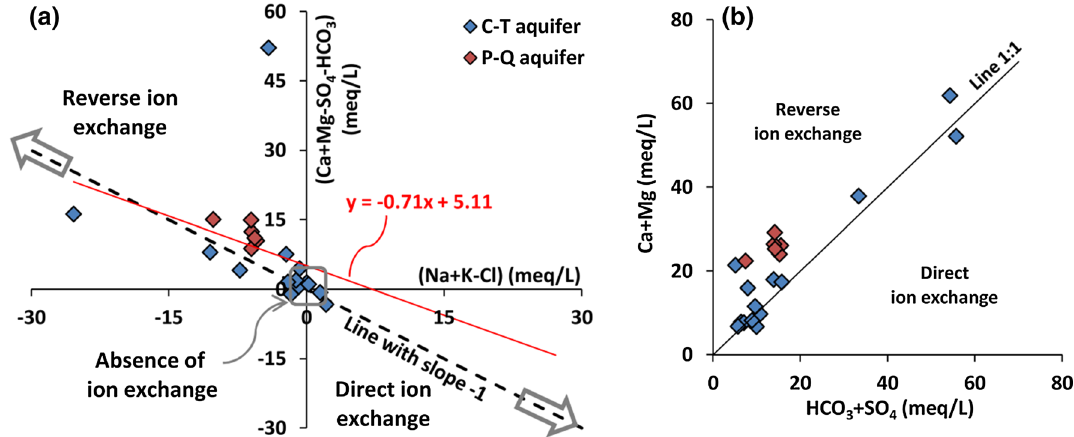
Fig. 7 Correlation diagram a [(Ca + Mg) − (HCO 3 + SO 4 )] versus [(Na + K) − Cl] b (Ca + Mg) versus (HCO 3 + SO 4 ). C-T = Cenomanian-Turo- nian, P-Q =